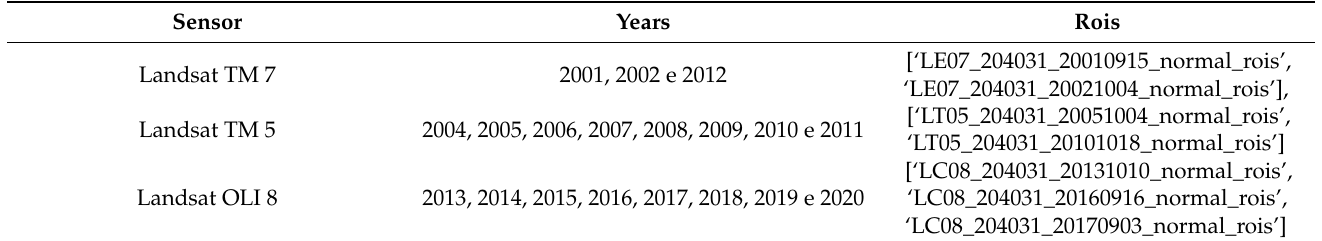
Table 3. Description of the images used to collect the classification samples.